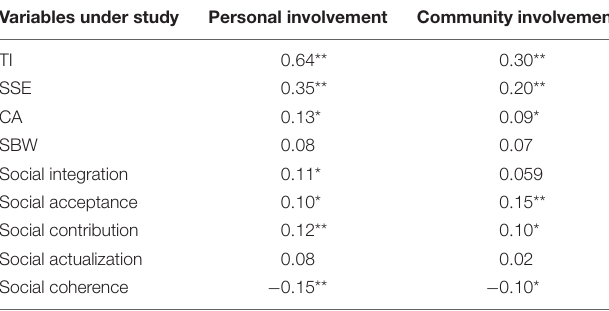
TABLE 1 | Correlations between TI, SSE, CA and SBW with personal and community involvement. Variables under study